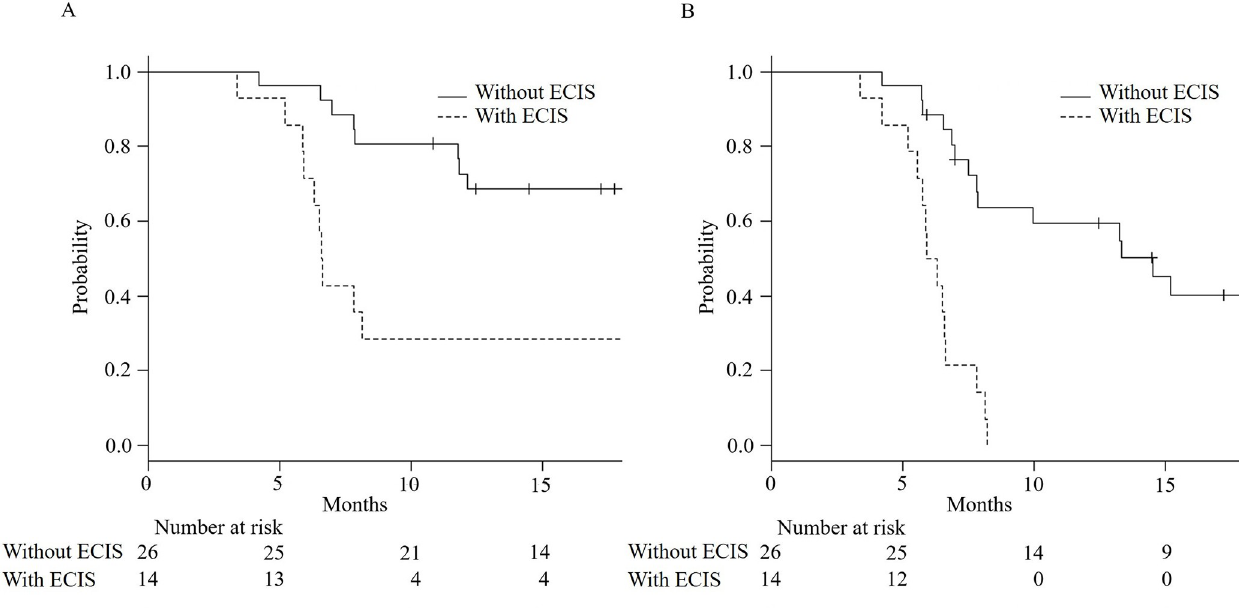
Fig 3. Kaplan–Meier curves for functional (A) and radiological (B) progression-free survival in patients with or without edematous changes in the interlobular septum (ECIS). Both curves (A and B) showed statistical differences (P < 0.001 in both).